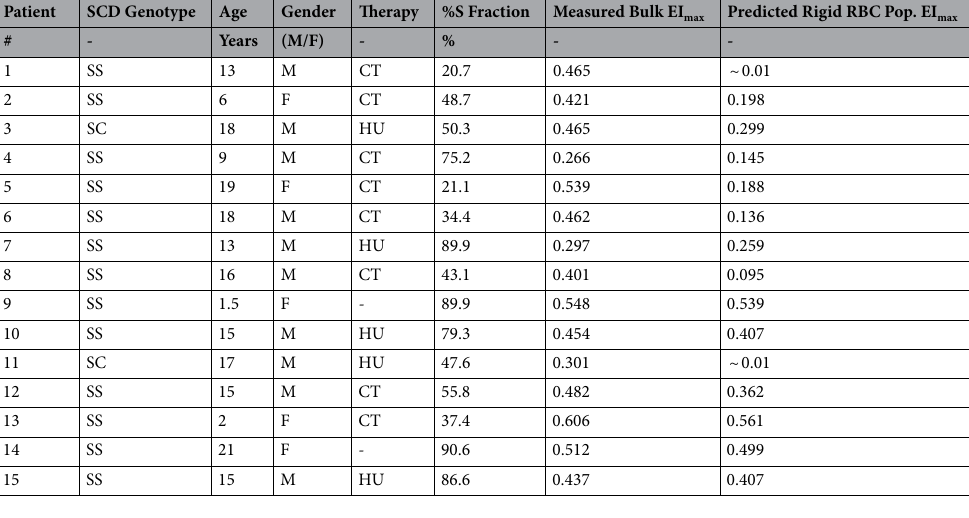
Table 1. Sickle cell disease patient general information and ektacytometry maximum elongation values. Information includes SCD genotype, age in years, gender (male or female), current patient therapy chronic transfusions (CT) or Hydroxyurea (HU), %S fraction as determined by blood electrophoresis, and maximum EI measured via ektacytometry in the actual SCD patient blood sample. The table also includes the predicted EI max of rigid population, i.e., %S Fraction. Missing therapies indicate the patient is not under any type of treatment at the time of the